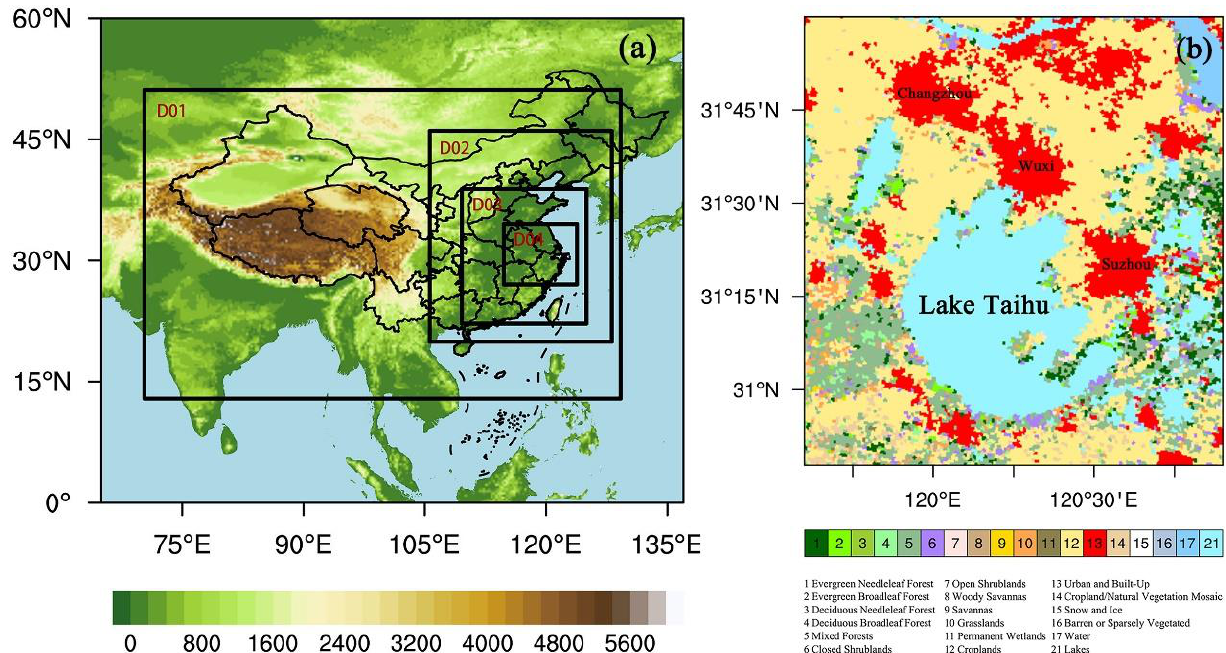
Figure 3. ( a ) The domains for WRF simulations and the terrain height for the outer domain (unit: m); ( b ) The land use of study area, derived from the 20-category IGBP-Modified MODIS.